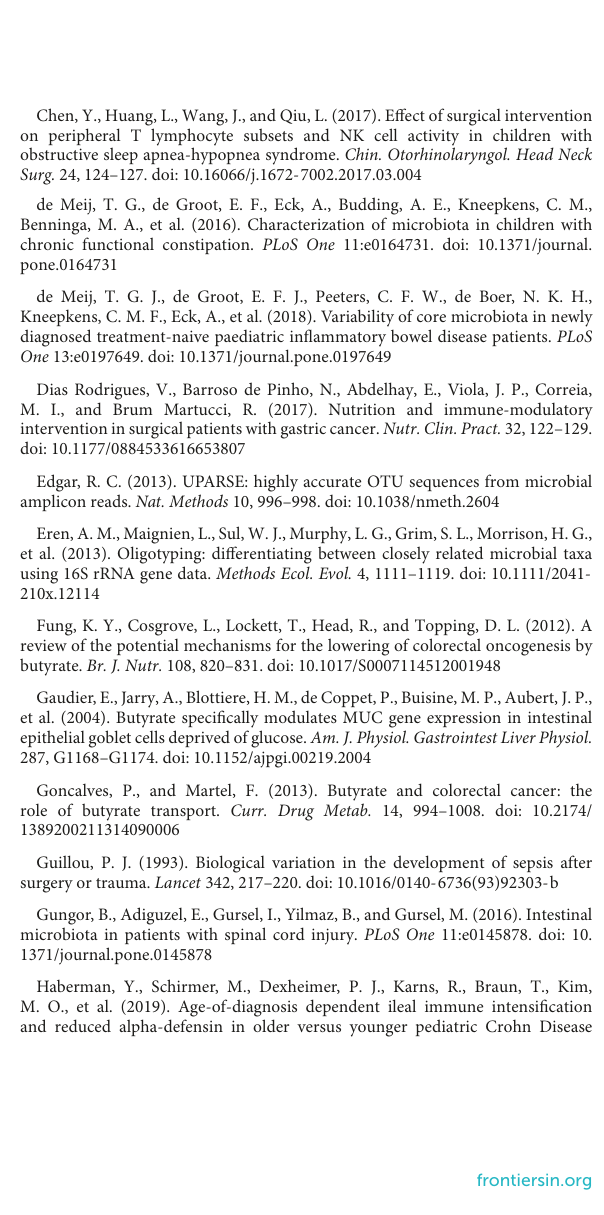
SUPPLEMENTARYFIGURE1 Gating strategy of lymphocyte subsets. Flow cytometry dot plots illustrate the gating of B cells, CD3 + T cells, NK cells, and CIK cells. These cells were indicated by the expression of CD19+, CD3+, CD16+56+, and, CD3+CD16+56+, respectively. CD8+ T cells or CD4+ T cells were further gated on CD3 + T